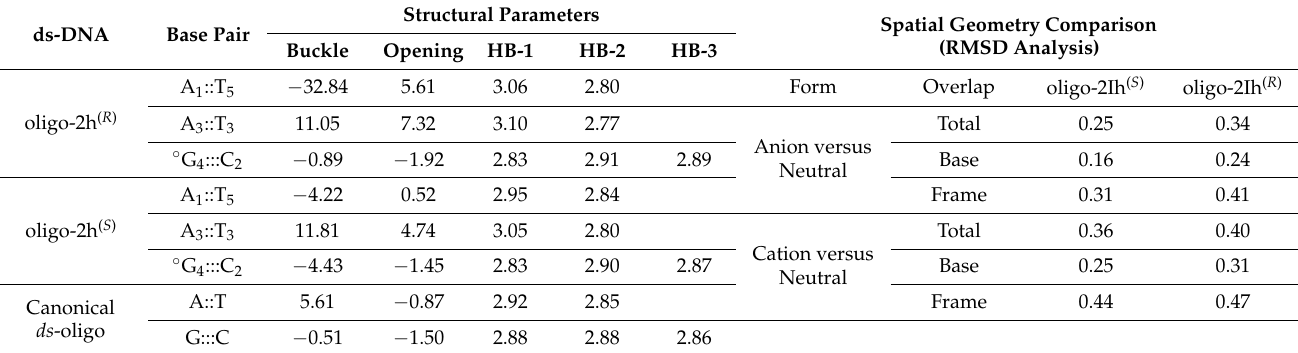
Table 1. The structural local base pair parameters in [ ◦ ] according to the standard DNA reference frame and hydrogen bond length in [Å]. Hydrogen bond notation: HB-1: Ade(N 1 ), Thy(N 3 ), Gua(N 6 ), and Cyt(O 4 ); HB-2: Ade(N 6 ), Thy(O 4 ), Gua(N 1 ), and Cyt(N 3 ); HB-3: Gua(N 2 ) and Cyt(O 2 ). Root- Mean-Square Deviation (RMSD) of atomic positions in [Å 2 ], calculated for oligo-2Ih ( R ) and oligo- 2Ih ( S ) in their Neutral, Anionic, and Cationic forms. Structural Parameters Spatial Geometry Comparison (RMSD Analysis)Buckle Opening HB-1 HB-2